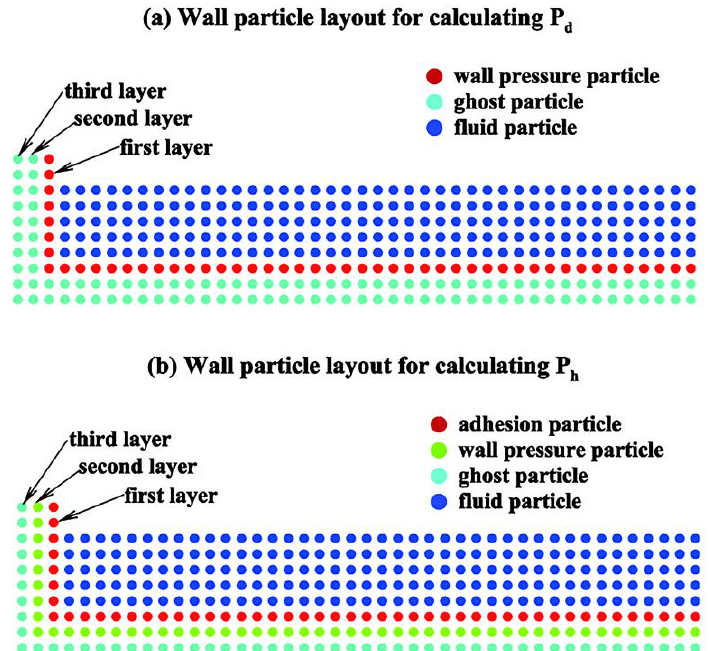
Figure 2. Wall particle layouts for calculating the ( a ) dynamic pressure and ( b ) hydrostatic pressure.